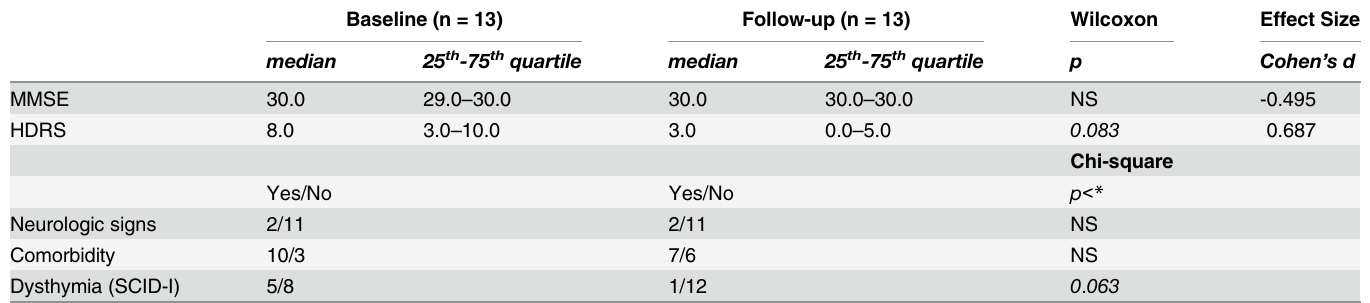
Table 2. Clinical features of the CD subjects at follow-up.